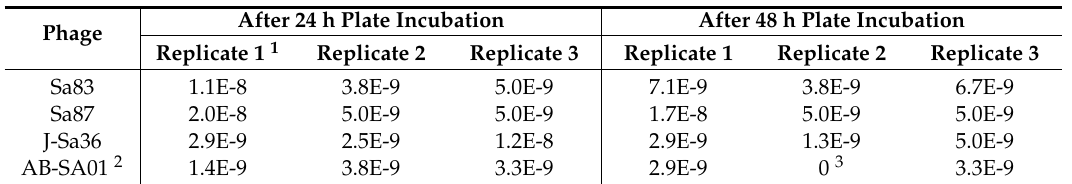
Table 4. Apparent frequency of intrinsic phage resistance in populations of S. aureus sensitive to AB-SA01 and its component